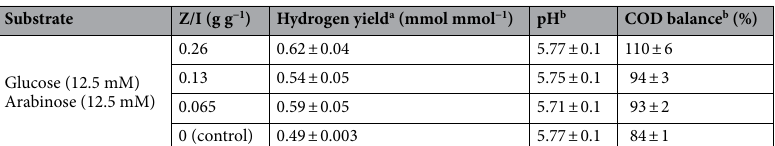
Table 1. Hydrogen yields, pH and COD balance from batch experiments with C5 and C6-sugars. The results are the average and standard deviations for duplicate assays. a mmol of hydrogen produced per mmol of sugar consumed. b At the end of the batch